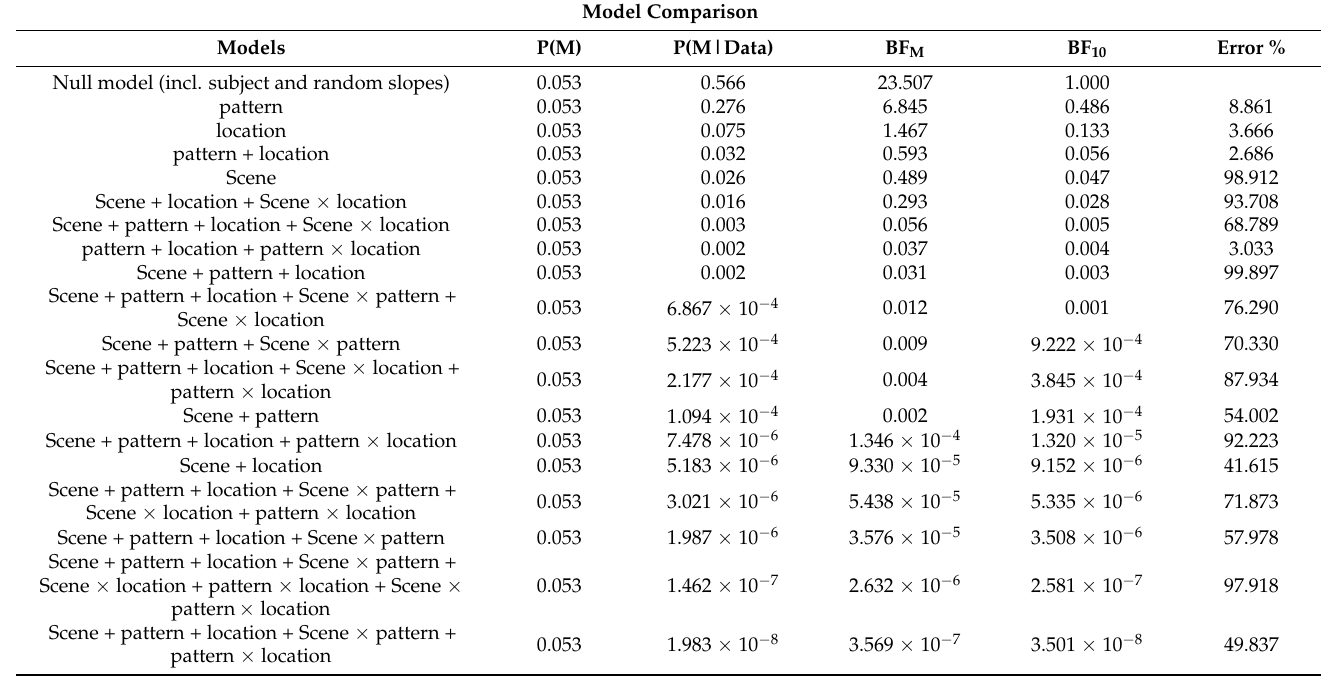
Table 6. Model comparison using Bayesian rmANOVA in y -axis gaze